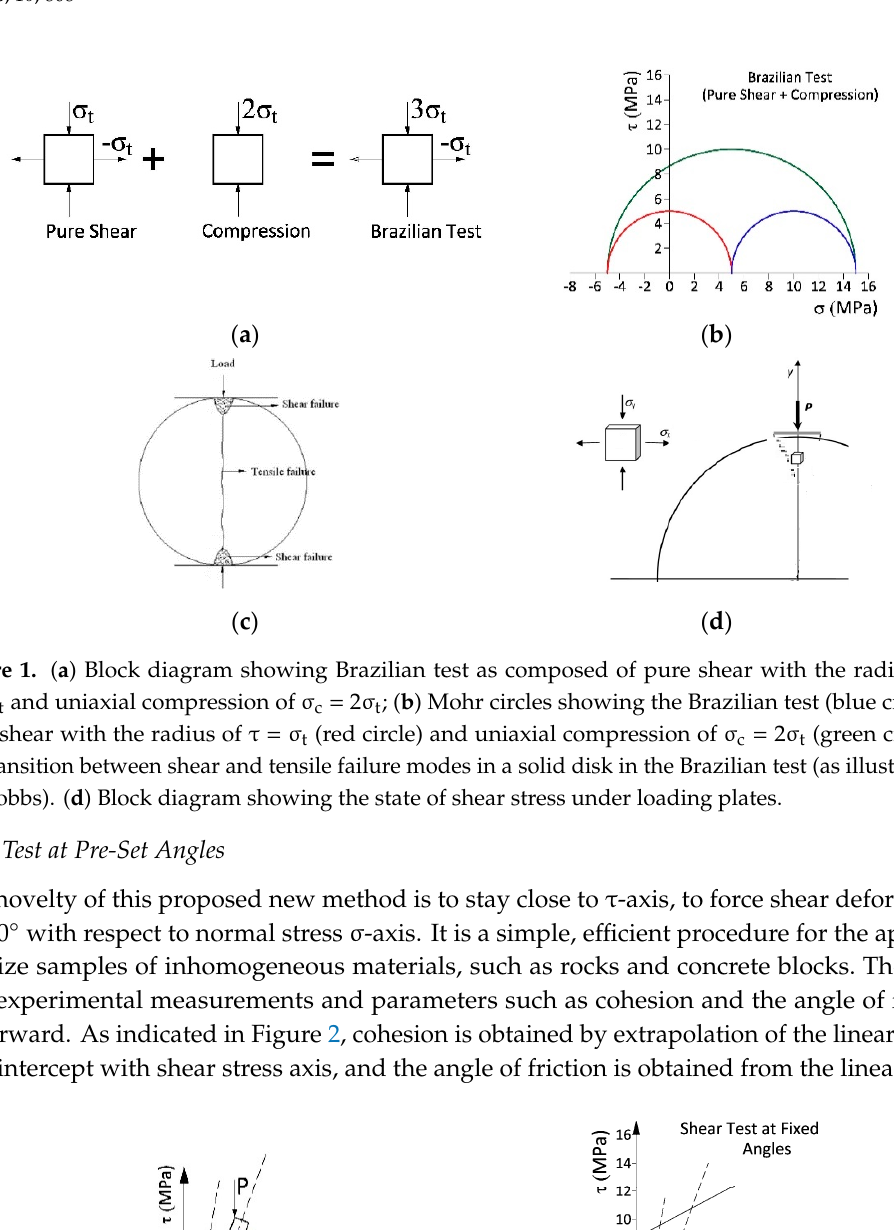
Figure 1. ( a ) Block diagram showing Brazilian test as composed of pure shear with the radius of τ = σ t and uniaxial compression of σ c = 2 σ t ; ( b ) Mohr circles showing the Brazilian test (blue circle), pure shear with the radius of τ = σ t (red circle) and uniaxial compression of σ c = 2 σ t (green circle). ( c ) Transition between shear and tensile failure modes in a solid disk in the Brazilian test (as illustrated by Hobbs). ( d ) Block diagram showing the state of shear stress under loading plates.